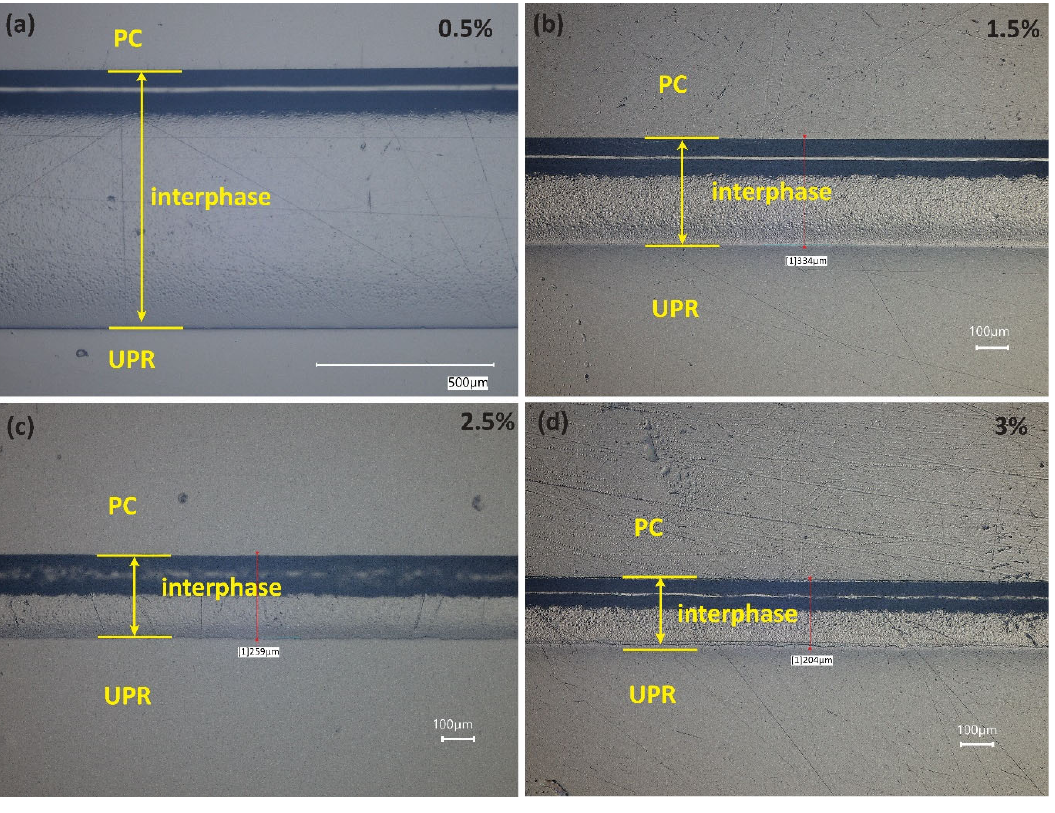
Figure 4. Optical micrographs of UPR–MEKP mixture for MEKP/UPR weight ratios of ( a ) 0.5%, ( b ) 1.5%, ( c ) 2.5%, and ( d ) 3%.